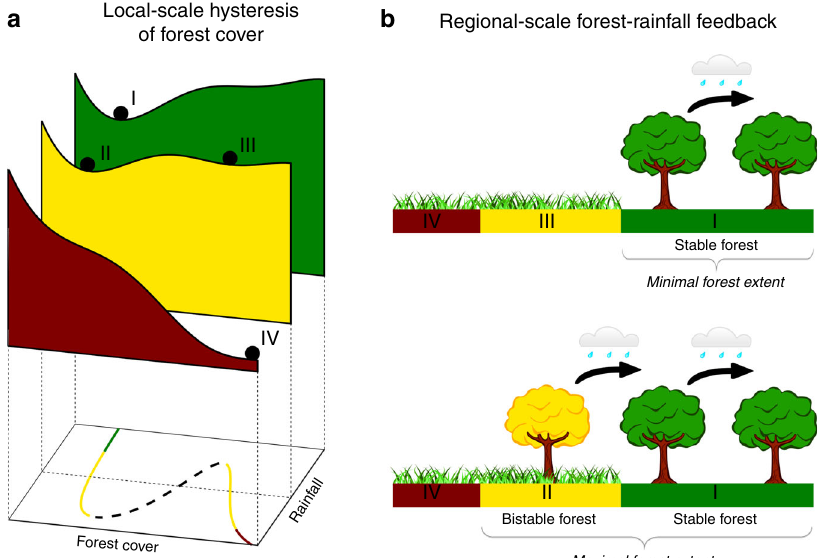
Fig. 1 Local-scale hysteresis of forest cover and its interaction with the regional forest – rainfall feedback. a A stability landscape of forest cover against rainfall levels. At high rainfall levels, high forest cover is uni-stable (I; green), called ‘ stable forest ’ throughout this paper. At intermediate rainfall levels, high forest cover (II) and low forest cover (III; nonforest) are bistable states (yellow). At low rainfall levels, only the nonforested state can exist (IV; red). b The regional forest – rainfall feedback ampli fi es hysteresis: minimal forest extent includes only stable forests (green), thereby lacking the rainfall enhancement by bistable forests; maximal forest extent includes forests that are bistable (yellow), which then contribute to downwind rainfall levels and may stabilize forests on those